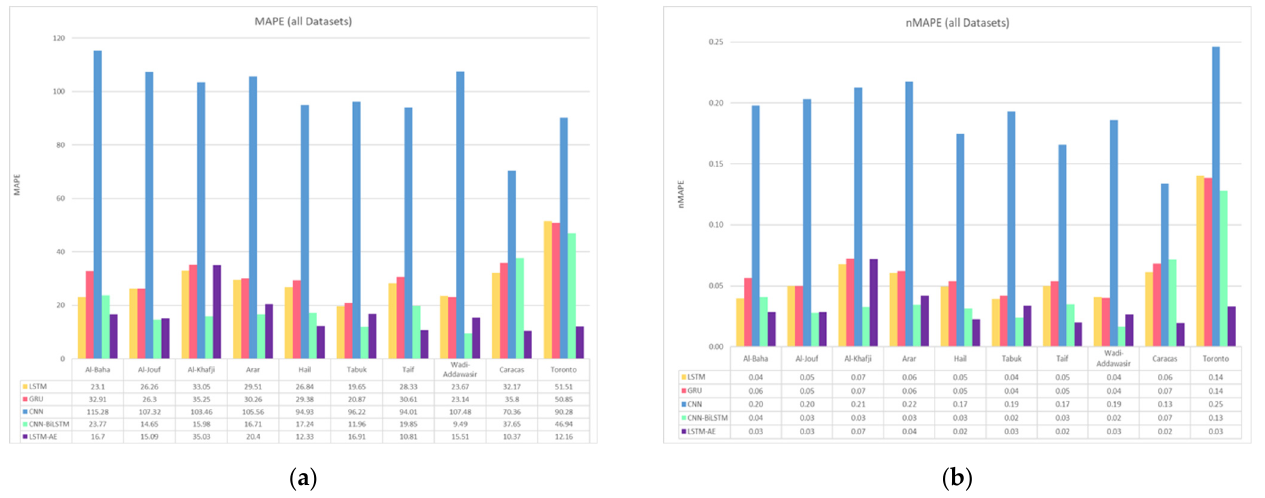
Figure 25. Forecasting results of 5 models for all datasets ( a ) MAPE; ( b ) nMAPE. Figure 26 shows the FS results based on MAE and RMSE for all the forecasting mod-